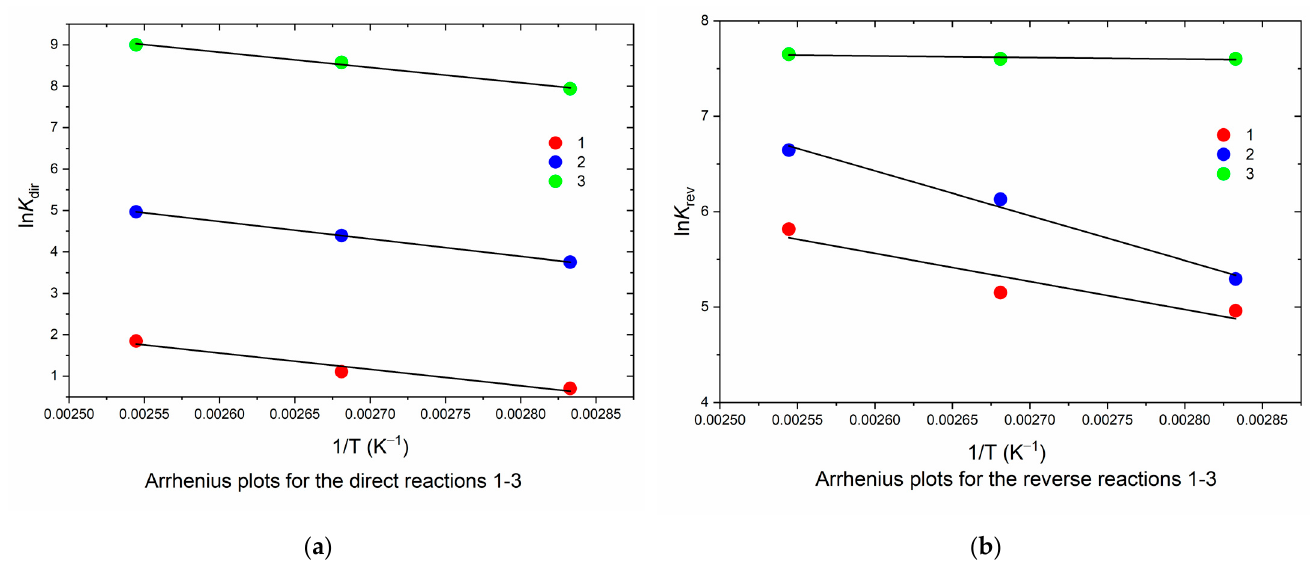
Figure 1. ( a ) The dependencies of ln k dir and ( b ) ln k rev on 1/ T for reactions (1), (2), and (3). The values of E a and pre-exponential coefficient, A, with a relative error of correlation, not exceeding 4%, are obtained by fitting the dependencies ln k dir and ln k rev of reactions (1)–(3) on the inverse temperature in accordance with the Arrhenius equation, k = Ae (cid:3127)(cid:3254)(cid:3276) (cid:3267)(cid:3269) (Table 4). Table 4. The parameters of the temperature dependencies of the rate constants of direct and reverse reactions of TS and DCS dismutation.